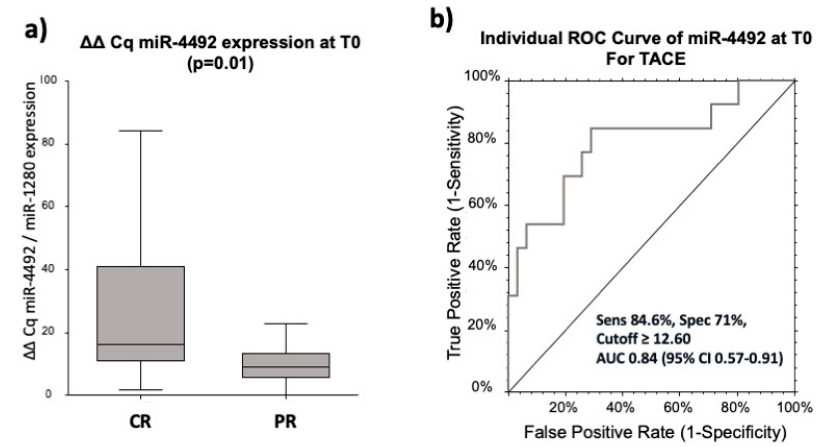
Figure 6. MiR-4492 predicts therapy response to trans-arterial chemoembolization (TACE). Mean ∆∆ Cq expression of miR-4492 in CR and PRPD in TACE-treated patients ( a ). ROC analysis of miR-4492 ( b ).